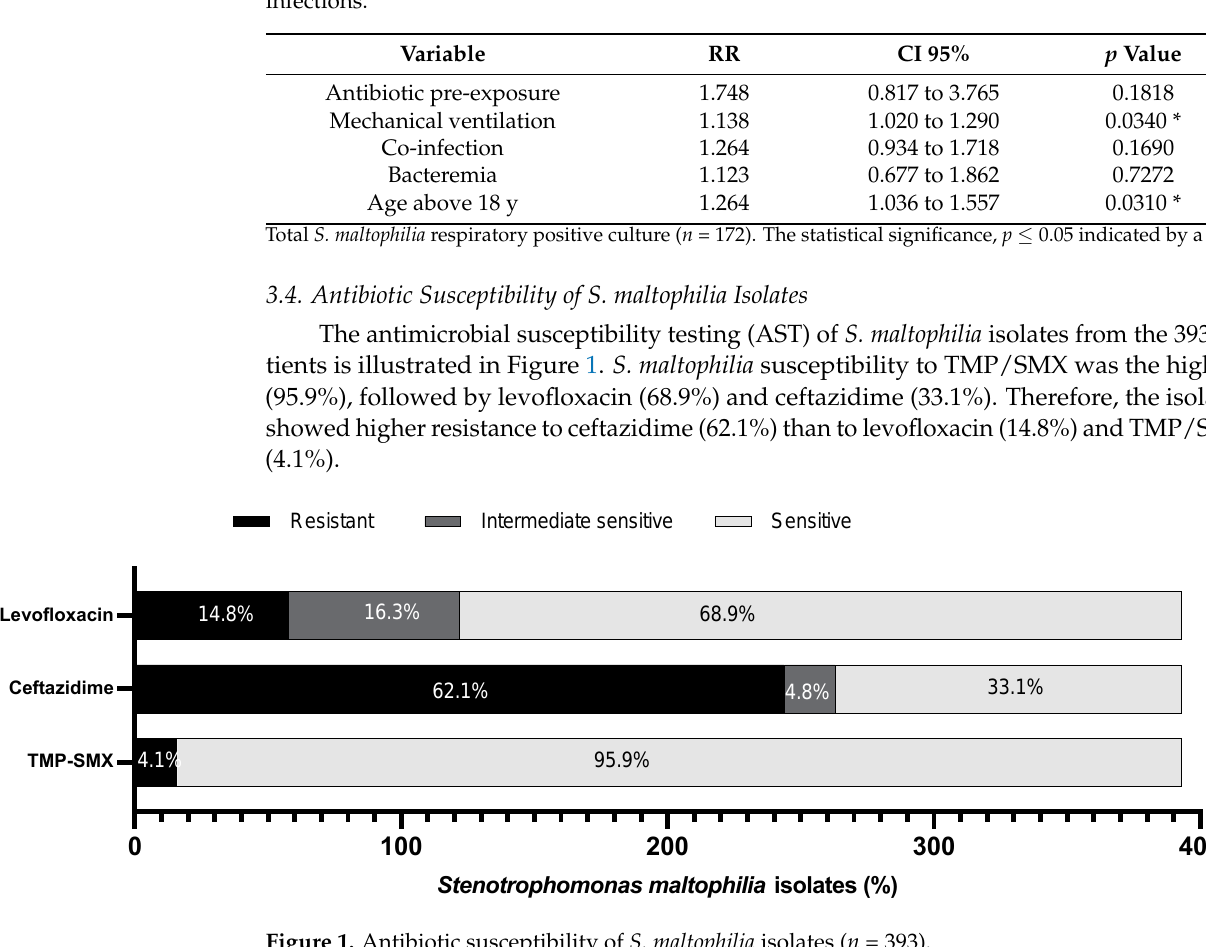
Table 4. Risk factors and relative risk of mortality among ICU patients with S. maltophilia respiratory infections.